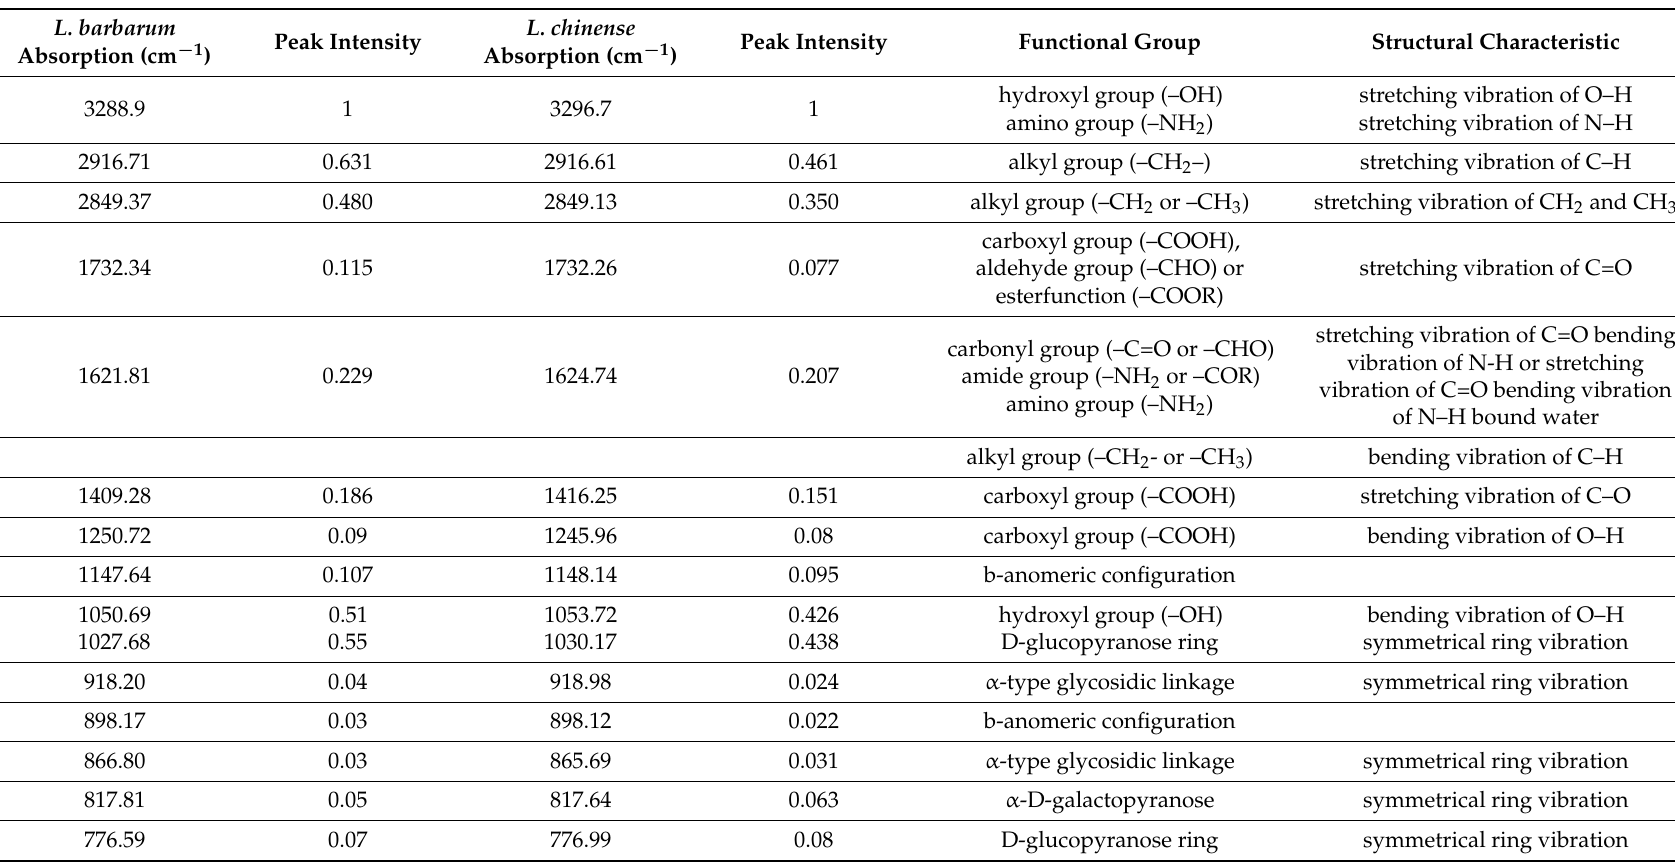
Table 3. Peak analysis of the attenuated total reflection Fourier-transform infrared (ATR-FT-IR) spectra of the functional groups of L. barbarum L. and L. chinense Mill. fruits cultivated in central